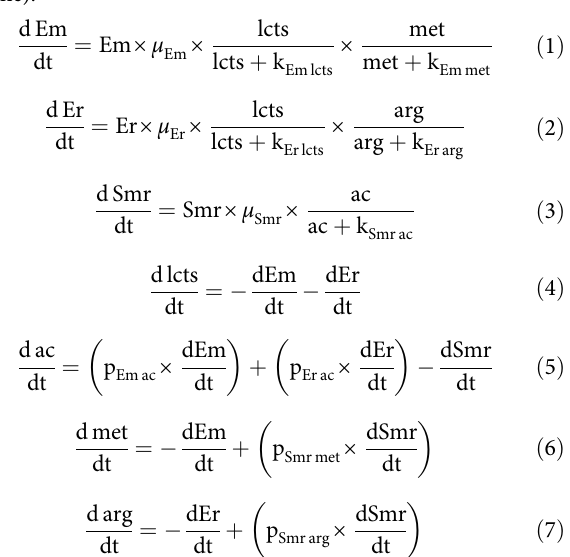
(e.g., k Em lcts ), which are in units of cells/ml. Production terms (e.g., p Em ac ) are in units of cells/cell. Default values and parameter descriptions can be found in Supplementary Table 1.